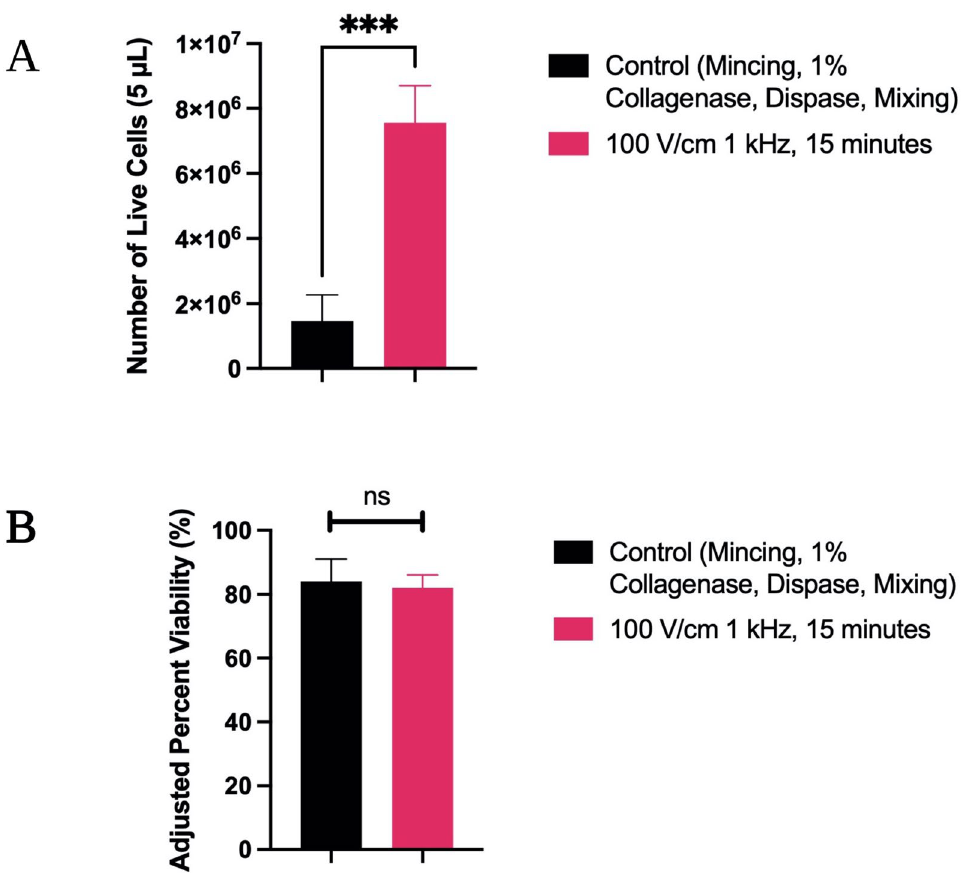
Figure 7. Human clinical glioblastoma results. ( A ) Illustrates the number of live cells isolated from size and volume-matched tissue sections dissociated using control and electrical protocols. The electrically treated group had a statistically significantly higher number of live cells than the control preparation with p < 0.001. ( B ) Illustrates the percent viability of chemical/mechanical and electrical preparations, as adjusted using an untreated control. The treated groups were not found to be significantly different in terms of the viability. All data on cellular recovery and viability was collected using a Countess Automated